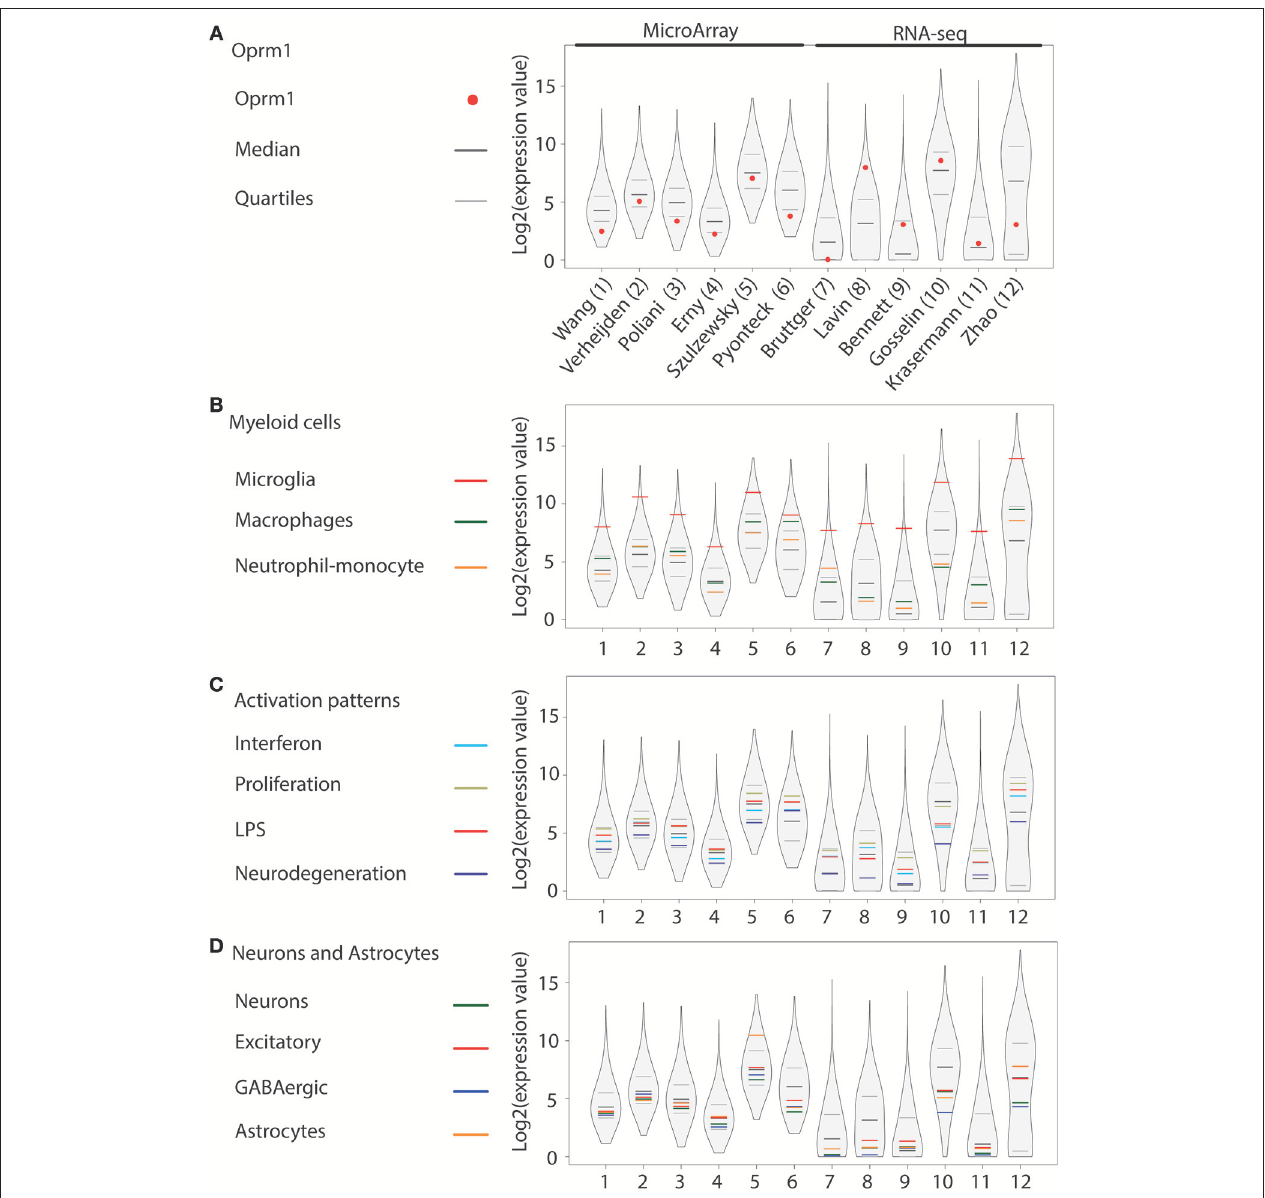
FIGURE 1 | Oprm1 and gene clusters expression in mouse whole brain microglia datasets. Expression levels of the genes identified in each dataset are represented in violin plots demonstrating the median, as well as the 25th and 75th quartiles. Datasets are represented by name of the first author in (A) , which are denoted numerically in (B–D) . (A) Expression of Oprm1 is below the median in purified microglia assayed with MA, and fluctuates above and below the median in purified microglia assayed with RNA-seq. (B) Expression values of the Myeloid cell clusters demonstrate a high expression of Microglia-related genes which are in the 75th quartile in all the datasets analyzed. (C) Expression values of the Activation pattern clusters are below the 75th quartile in all but one dataset (dataset #6). (D) Expression values of the Neurons and Astrocytes clusters are below the median in 5 out 6 of the datasets derived from MA assays, whereby the Astrocyte-related genes have expression values above the 75th quartile in dataset #5. When assayed with RNA-seq, the Astrocyte-related genes are below the median, except for dataset #12, where the values are above the median.